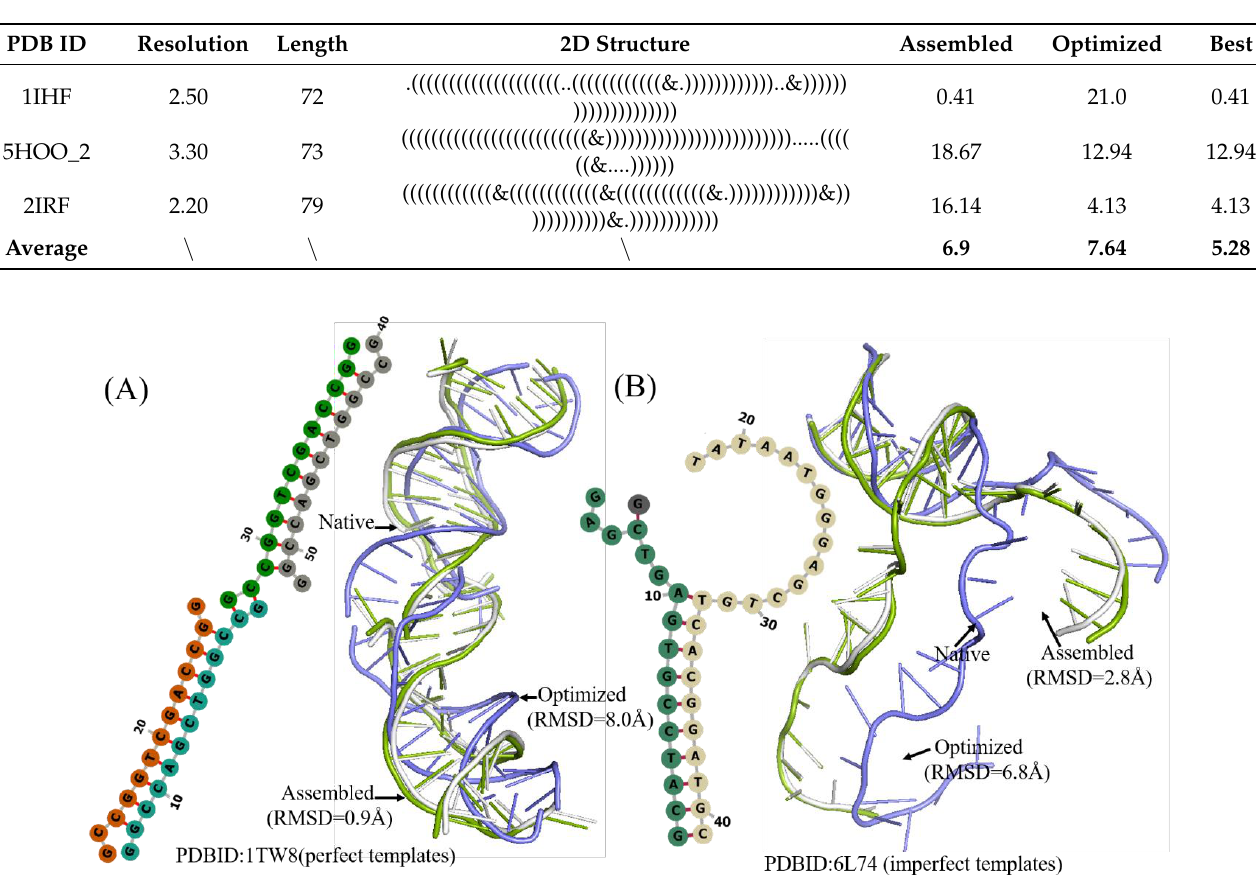
Figure 7. Two examples of the 3D structures of multi-chains DNA predicted by 3dDNA. ( A ) The 2D and 3D structures of DNA 1TW8 with perfect template; the RMSD of assembled (green) and optimized (blue) structures with a native one (grey) are 0.9Å and 8.0 Å, respectively. ( B ) The 2D and 3D structure DNAs 4L74 with imperfect template; the RMSD of assembled (green) and optimized (blue) structures with a native one (grey) are 2.8 Å and 6.8 Å, respectively.